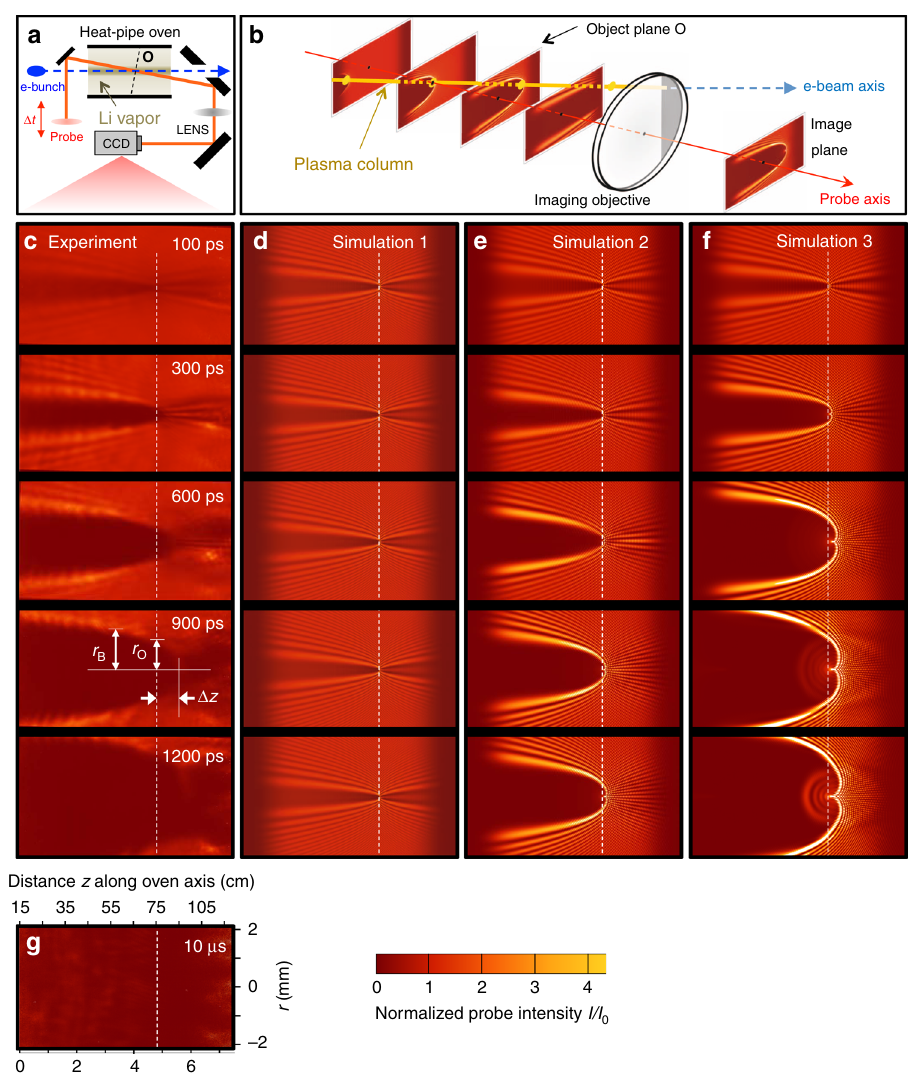
Fig. 1 Imaging of expanding Li + ion column following electron wake excitation. a Overview of experimental setup, showing path of laser probe pulse (orange solid line) through plasma column (dashed blue line) at grazing angle 8 mrad with variable time delay Δ t after e-bunch excitation. The resulting diffraction pattern is imaged from vacuum object plane (O) onto a CCD. b Schematic depiction of evolving probe intensity pro fi le as it passes obliquely through plasma column and imaging lens. An obstruction blocked the gray area on the lens. c Experimental probe images for Δ t = 100, 300, 600, 900, and 1200 ps, normalized to unperturbed probe intensity I 0 (see color scale, lower right), averaged over 30 shots. See Supplementary Fig. 1 for comparative single-shot images. Dashed vertical white lines: intersection of plane O with plasma column. Each probe image is 4 mm high ×7.5 mm wide; horizontal dimension corresponds to projected distance 1.0 m along plasma column axis. d – f Simulated probe images for three plasma expansion models: d including dynamics of ions within initial plasma column only; e including impact ionization of ground state neutral lithium surrounding initial plasma column; f including impact excitation of neutral lithium to 2 P , 3 S , and 3 P states and impact ionization. g Experimental probe image at Δ t = 10 μ s, for which plasma column expanded well beyond fi eld of view. Horizontal and vertical scales in g also apply to each image in panels c – f